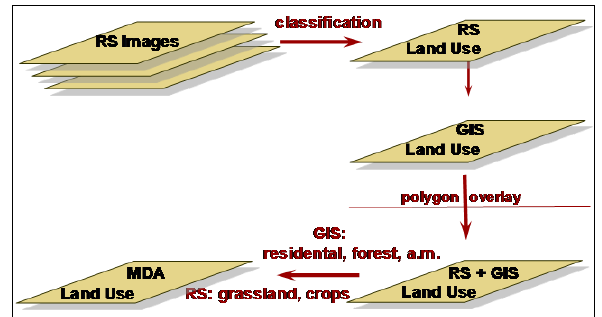
Figure 1. Schematic procedure of the MDA